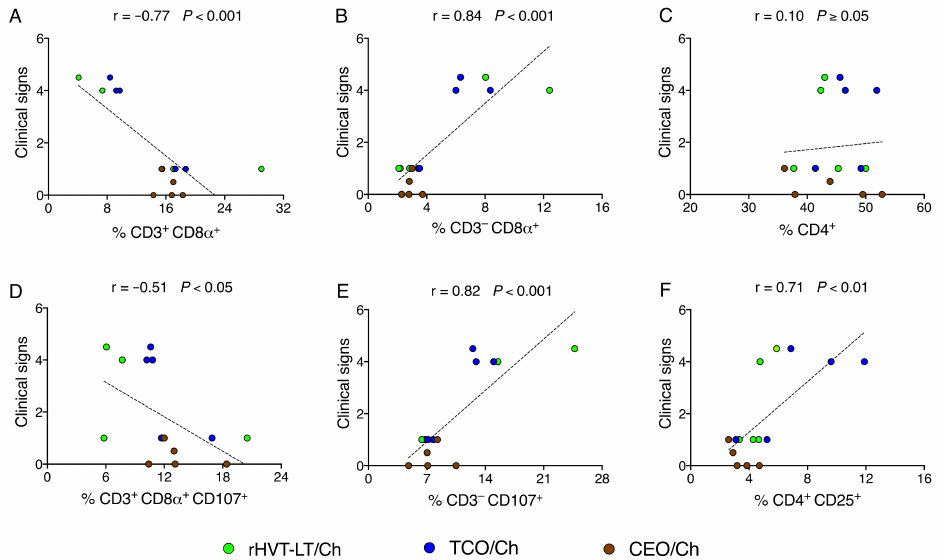
Figure 6. Correlation between clinical signs scores from vaccinated challenged chickens and per- centage of immune cells (%) at 4 dpch: ( A ) CTLs; ( B ) NK cells; ( C ) CD4 + T cells; ( D ) activated CTLs; ( E ) activated NK cells; ( F ) Tregs. Each dot represents an individual chicken; n = 15 for each correlation, where 5 chickens were included for each vaccinated challenged group; r value represents the Pearson correlation coefficient. An overlapping data point is sometimes observed. Statistical differences are defined at a significance level of p <